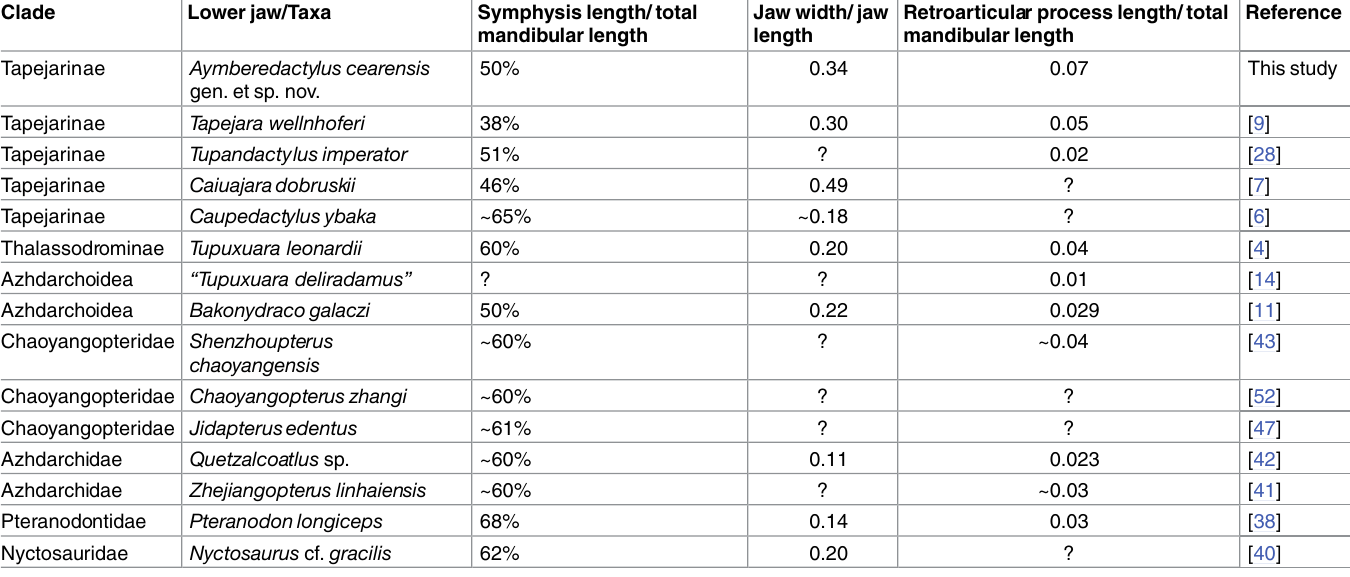
Table 1. Comparative selectedmandible ratiosof various pterosaurs.